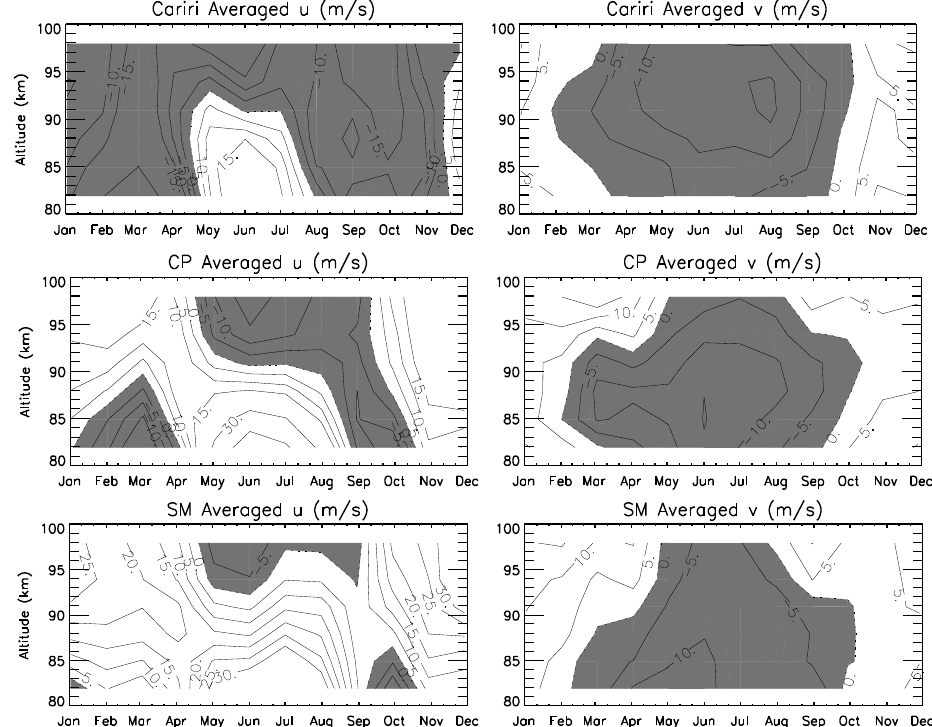
Figure 7. Averaged wind throughout the entire available data series for each site: zonal (left) and meridional (right) components. Grey means negative values and white positive. Positive values for the zonal (meridional) component correspond to eastward (northward)